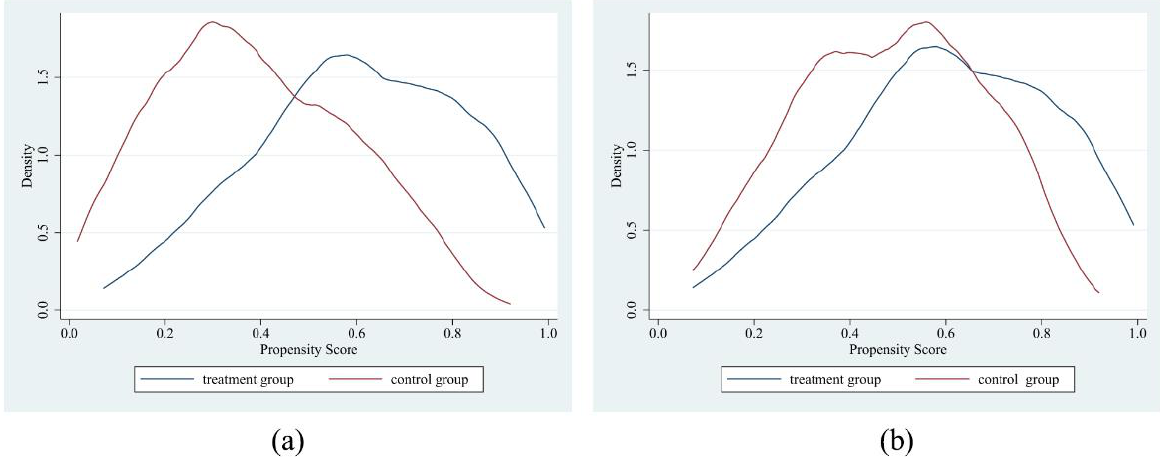
Figure 2. Propensity score probability density map. ( a ) before matching ( b ) after matching.